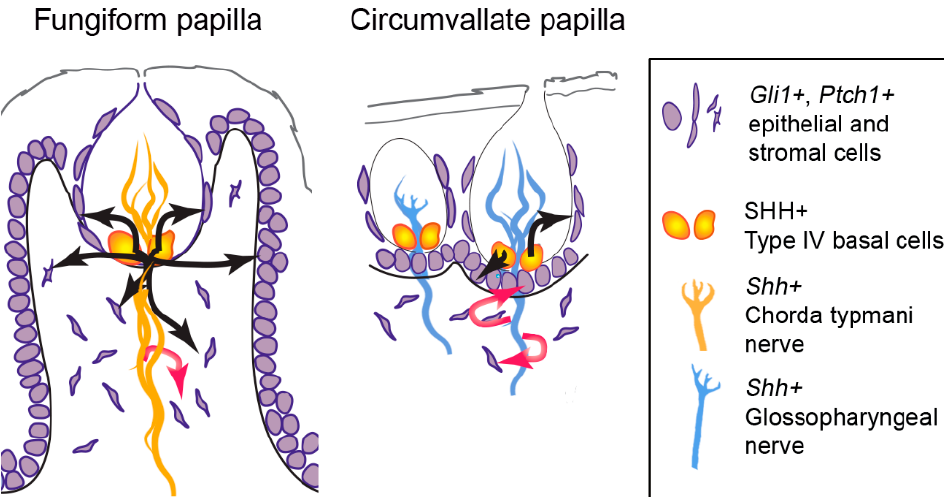
Figure 5. Paracrine SHH signaling in taste papillae epithelium and stroma. SHH ligand is present in Type IV basal cells and signals to Gli1+ and Ptch1+ HH-responding cells in the anterior tongue fungiform and posterior circumvallate papilla epithelium and stroma. Black arrows indicate epithelial paracrine signaling, and red arrows indicate neural paracrine signaling. In the fungiform papilla, epithelial SHH drives signaling in basal cells, perigemmal cells, and stromal cells (black arrows), while neural SHH signals to stromal cells (red arrow) (Note that neural paracrine signaling within the taste bud also has been suggested [108]). On the other hand, in the circumvallate papilla, epithelial SHH-responding targets are predominantly basal and perigemmal cells (black arrows), while neural SHH can target both basal and stromal cells (red arrows).